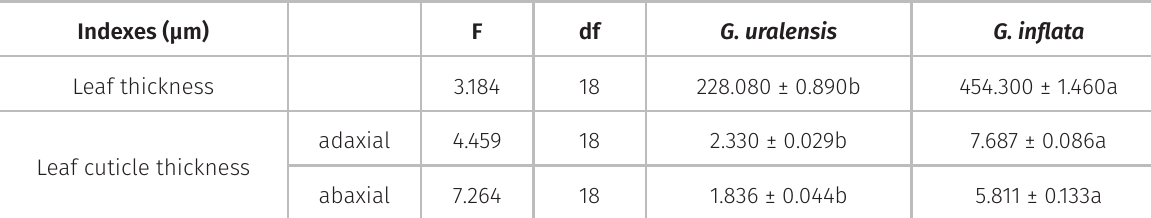
Table I. Comparison of leaf thickness and cuticle thickness between two species of